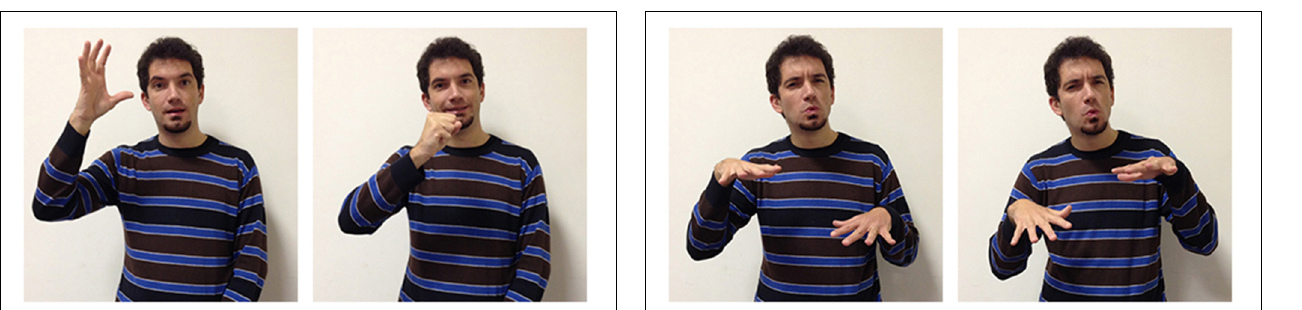
FIGURE 3 | LIS sign TO UNDERSTAND .